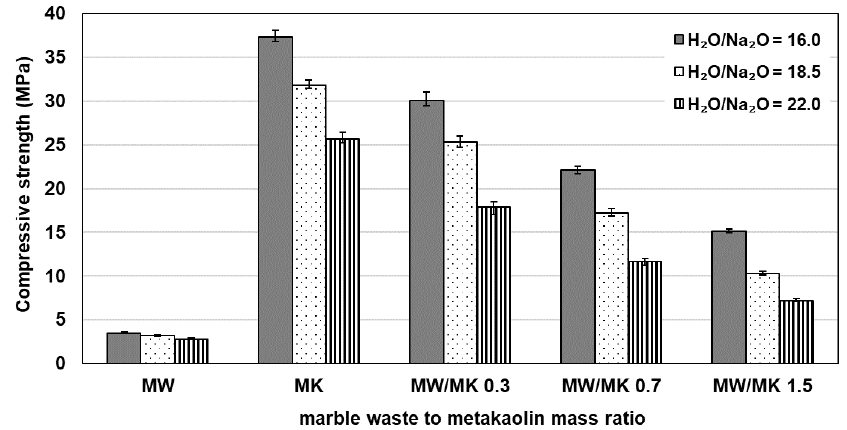
Figure 1. Effect of marble waste to metakaolin mass ratio on the 7-day compressive strength of the produced specimens after curing at 90 ◦ C for 24 h, as a function of H 2 O/Na 2 O molar ratios in the activating solution. The compressive strength of reference MW and MK specimens is also given for comparison.